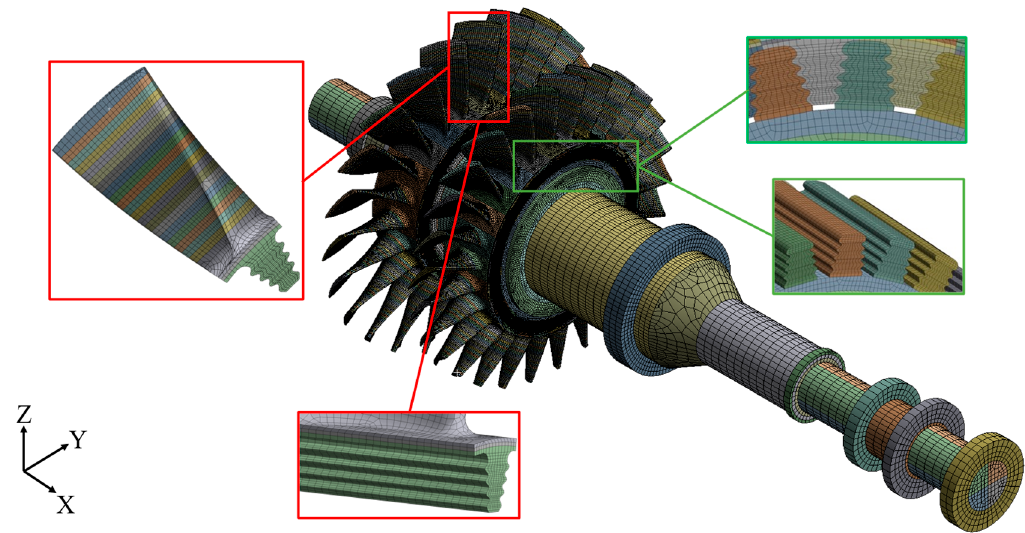
Figure 4. Finite element model of TRT rotor. Table 2. Material parameters of TRT Table 1. Information of finite element model.